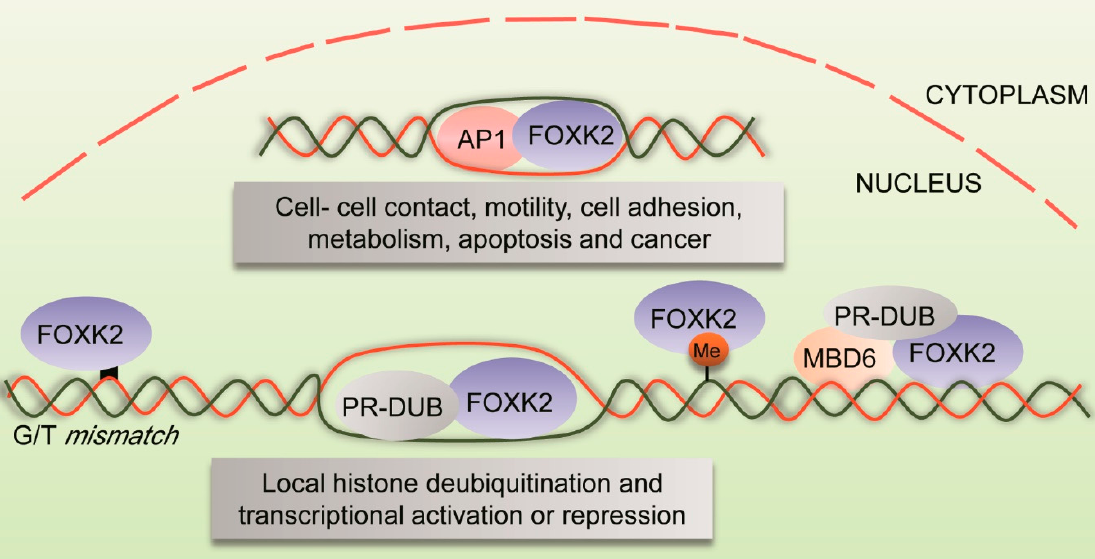
Figure 2. FOXK2 transcription factor and chromatin-associated events. FOXK2 recruits AP-1 to the chromatin, regulating genes involved in cell-cell contact, motility, cell adhesion, metabolism, apoptosis and cancer. Besides that, FOXK2 interacts with BAP1, a component of PR-DUB complex, leading to local histone deubiquitination and to repression and/or activation of transcription of target genes. In addition to these chromatin-associated events, FOXK2 binds to methylated DNA as well as interacts with MBD6 and PR-DUB complex, recruiting transcriptional complexes. Furthermore, FOXK2 is potentially implicated in DNA repair functions, where it binds to G/T-mismatch regions and interacts with BAP1 deubiquitinase. BAP1, BRCA1-associated protein 1; AP-1, activator protein-1; PR-DUB, polycomb repressive deubiquitinase; MBD6, methyl binding domain protein 6; Me, DNA methylation sites.